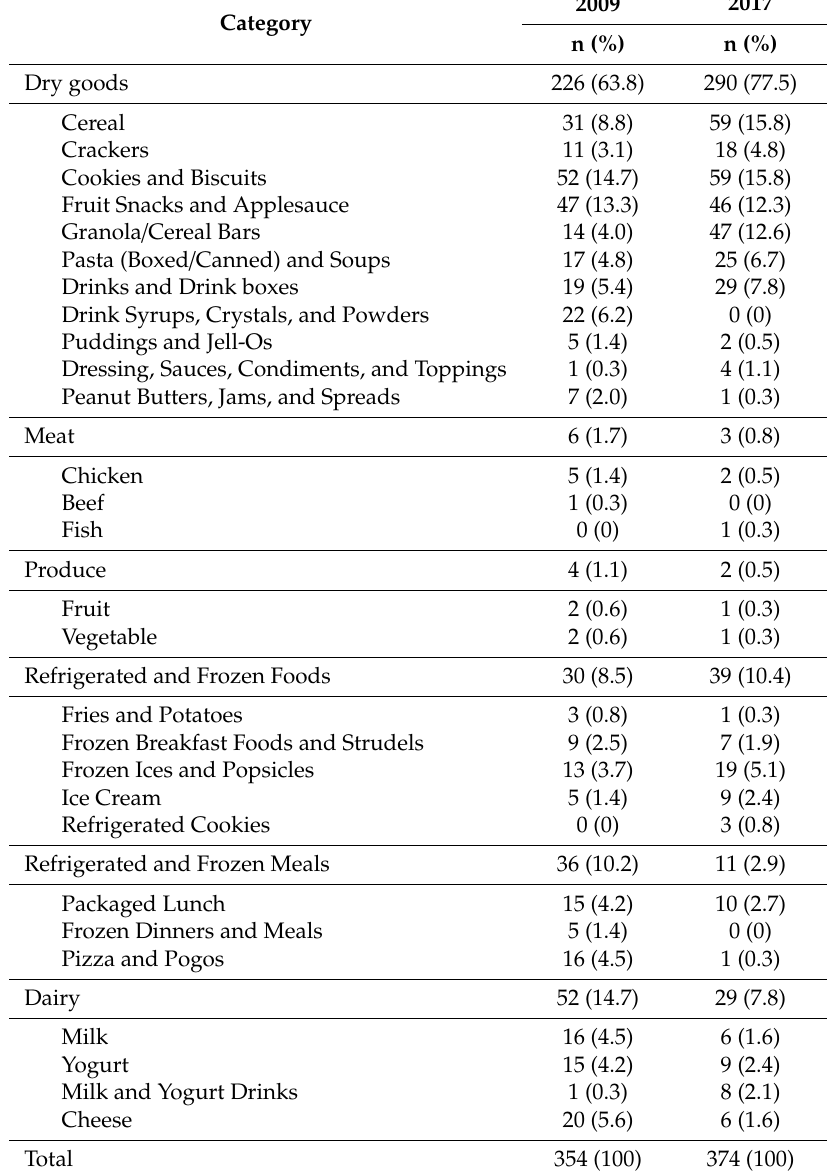
Table 1. Frequency of children’s foods in 2009 and 2017 by